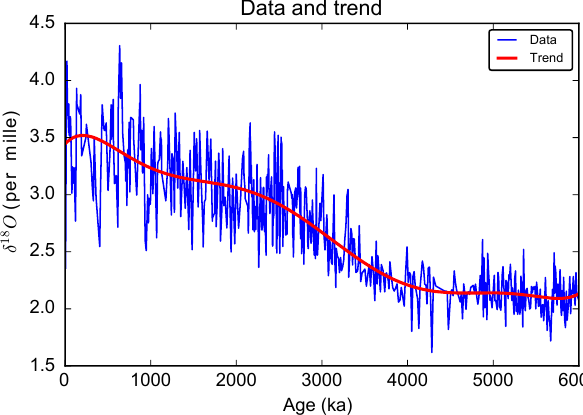
Figure 6. The time series and its 7th-degree polynomial trend.